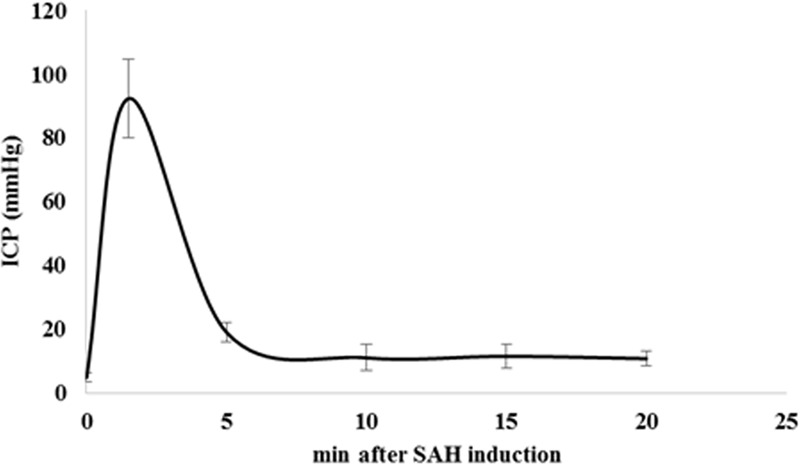
Time course of ICP changes after SAH induction. SAH induction was proven and controlled by continuous monitoring of ICP. We observed a prompt and sharp ICP increase in SAH animals up to 89 ± 17 mmHg indicating SAH induction. ICP values dropped to 11.5 ± 2 mmHg after 5 min of SAH induction and remained almost stable during next 15 min of monitoring. Values are given in mean and standard deviation. SAH, subarachnoid hemorrhage; ICP, intracranial pressure. Adopted from [Anzabi et al., in second review, microcirculation research (2018)].